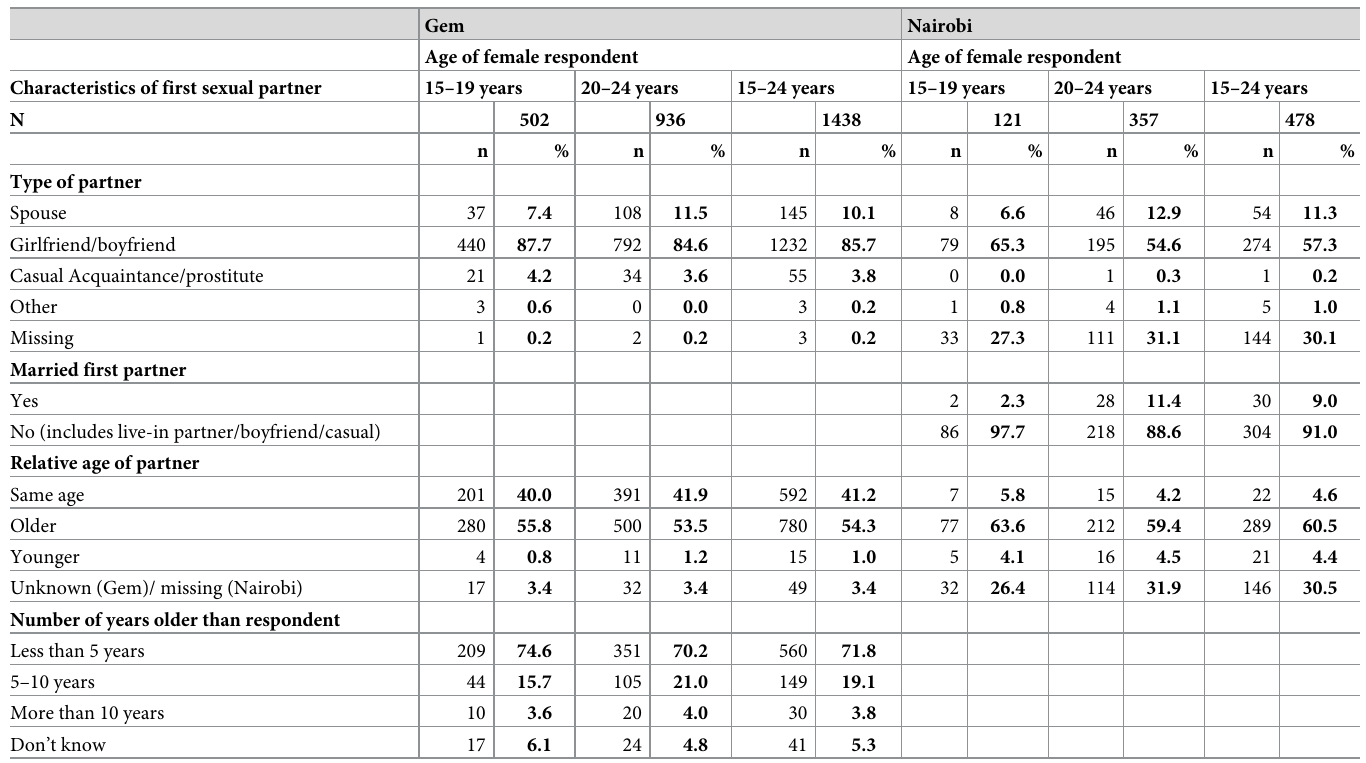
Table 4. Characteristics of first male sexual partner (reported by